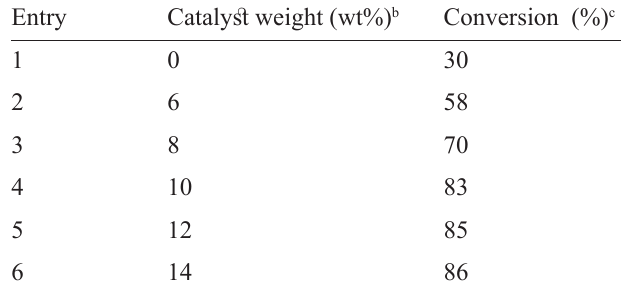
Table 4. Optimization of catalyst amount for the esterification of